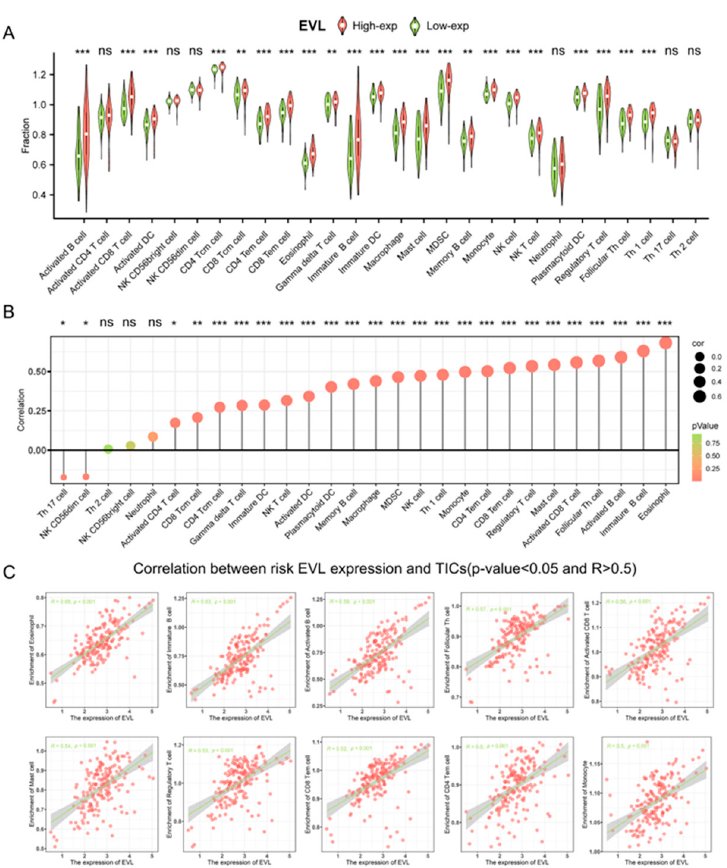
Figure 4. EVL expression is associated with immune cells infiltration in pancreatic cancer. ( A ) Com- parison of the different TICs infiltration levels under high and low EVL expression conditions. ( B ) Correlation analysis between the expression of EVL and the content of TICs. ( C ) 10 TICs showed strong correlation with EVL expression. EVL, Ena-VASP-like; TICs, tumor-infiltrating immune cells. * p < 0.05; ** p < 0.01; *** p < 0.001; ns, not significant.